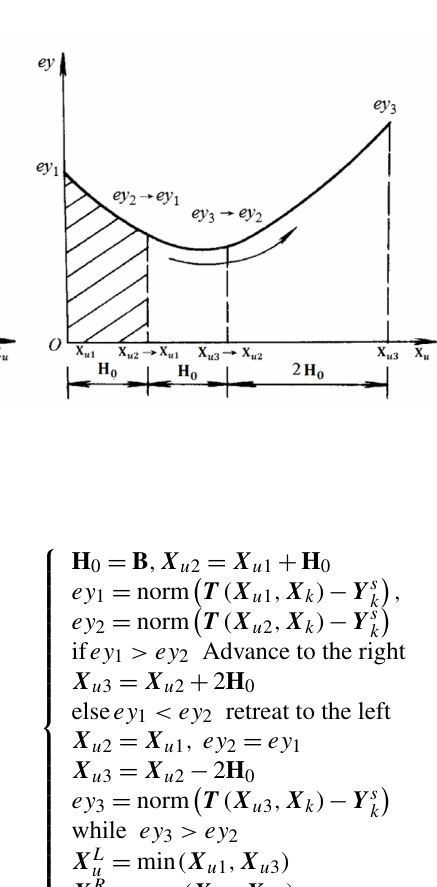
Figure 1. Schematic illustration of the eccentricity identification with randomness uncertainty.